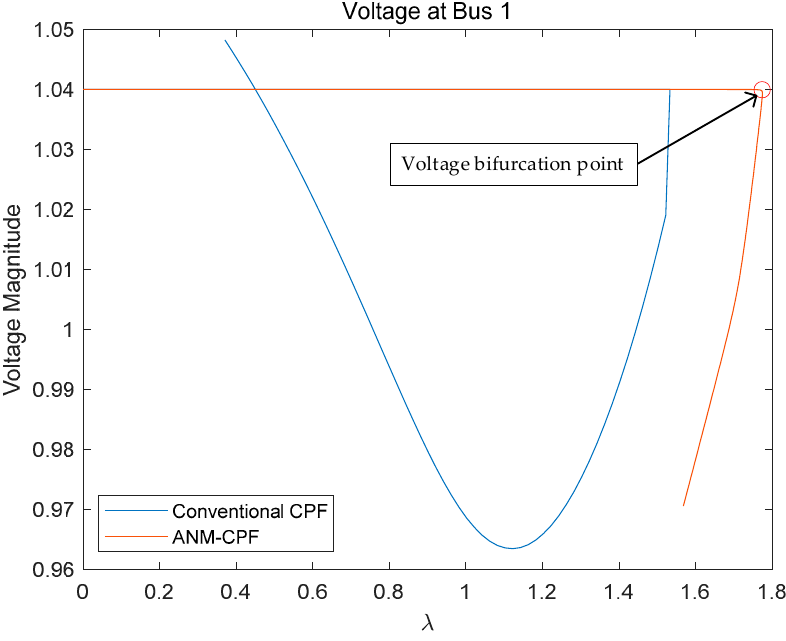
Figure 8. V-lambda curve of bus 1 when µ = 10 − 7 .